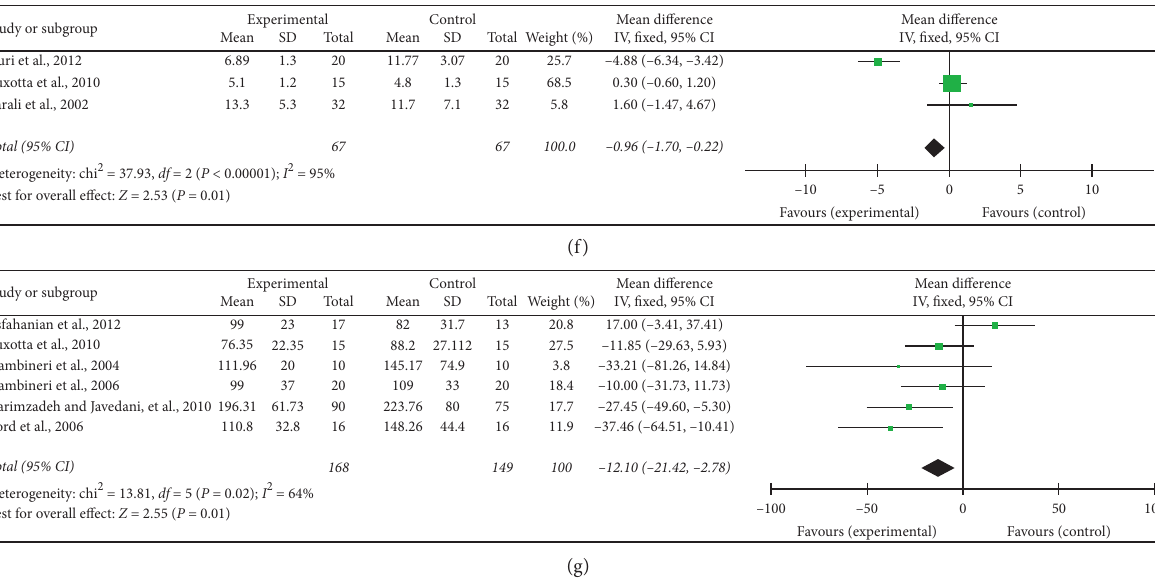
Figure 3: Effect of metformin on (a) body mass index; (b) waist circumference; (c) fasting insulin; (d) testosterone; (e) follicle-stimulating hormone; (f) luteinizing hormone; and (g) low-density lipoprotein.